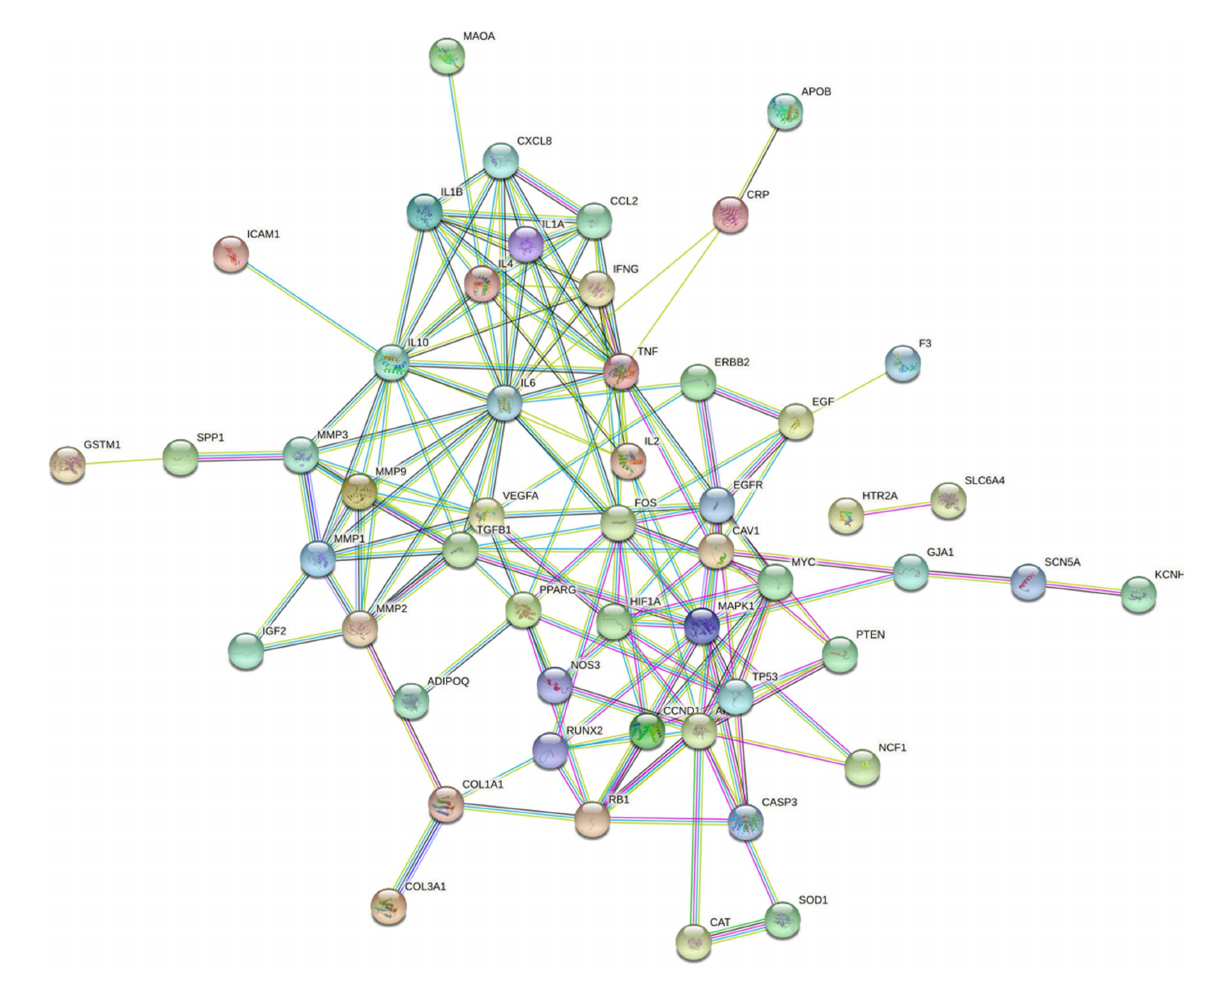
FIGURE 7 Protein–protein interaction (PPI) network. The more lines connected, the stronger the